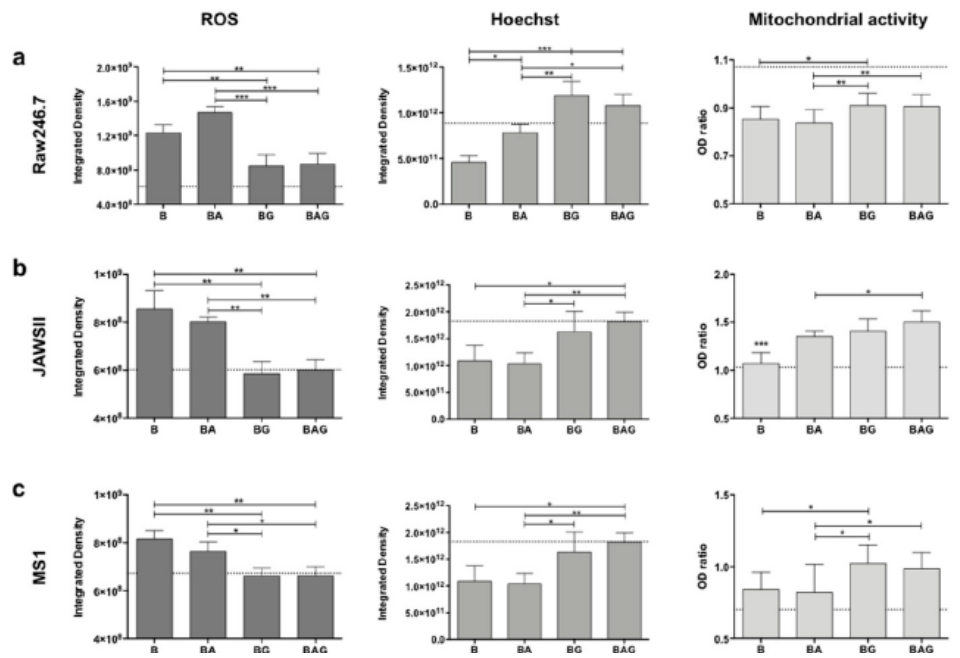
Figure 3. Reactive oxygen species (ROS) production, cell viability and mitochondrial activity in Raw246.7 ( a ), JAWSII ( b ) and MS1 ( c ) cells. The histograms represent mean values ± SD. The dotted lines represent the mean values of control cells. B = PFA-inactivated (PFAi) bacteria; BA = PFAi bacteria + ampicillin; BG = PFAi bacteria + Gas6; BAG = PFAi bacteria+ ampicillin + Gas6. * p < 0.05, ** p < 0.01, *** p <